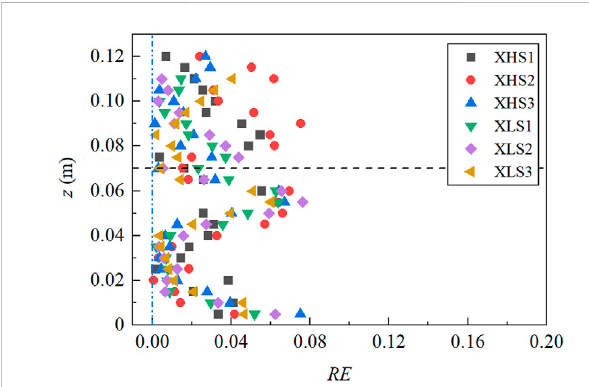
FIGURE 8 Relative error between the analytical model and the experimental velocityofrunsX.Theblackdottedlinerepresentstheheightoftheshort cylinders.